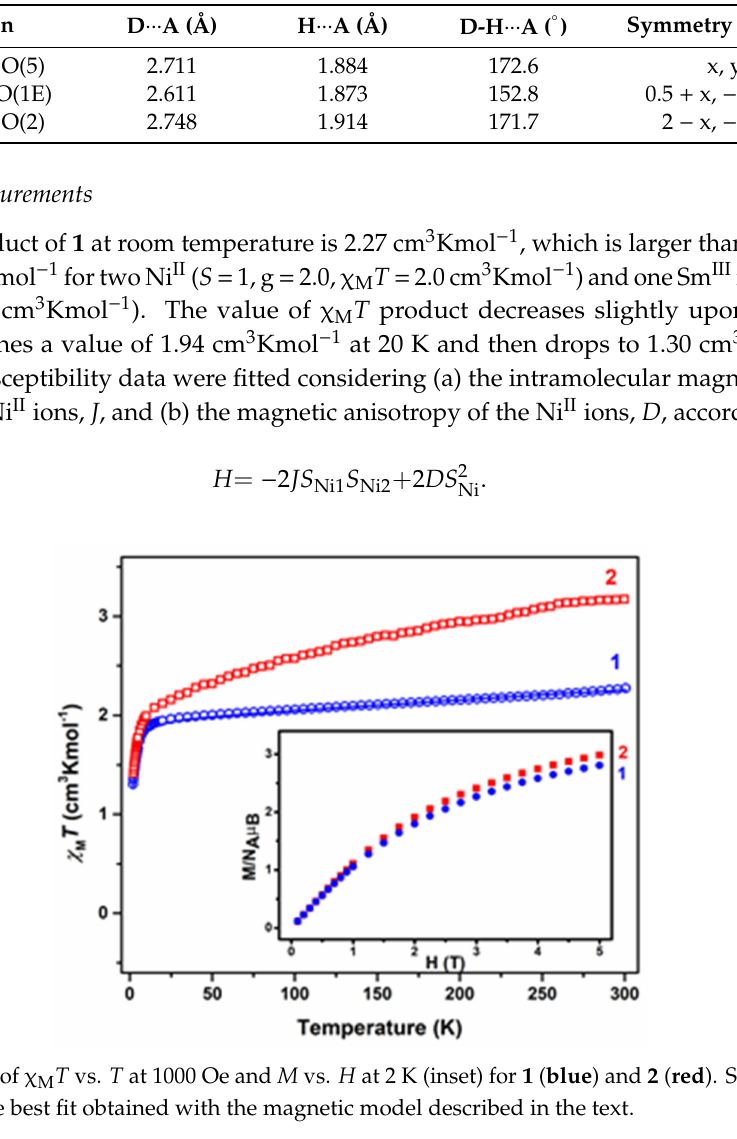
Table 2. Hydrogen bonds in 4 · 4EtOH · 4H 2 O.